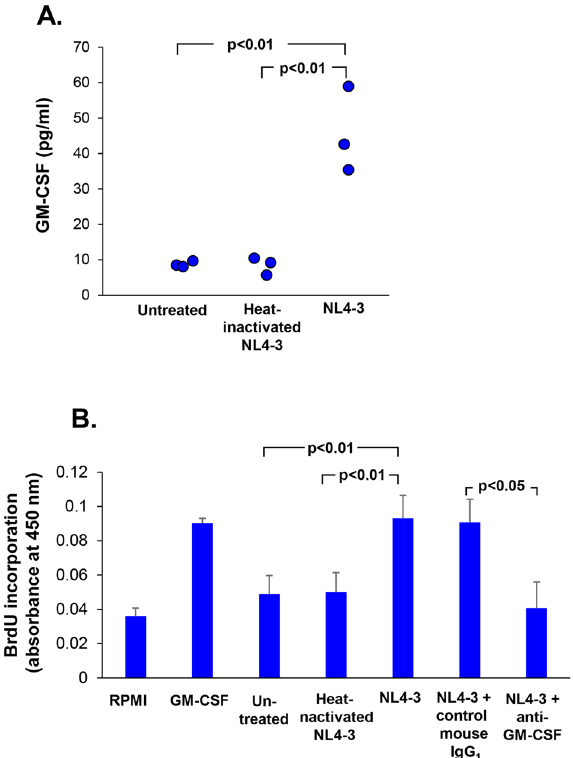
Figure 5. HIV-treated BC release GM-CSF that stimulates AM proliferation. ( A) Quantification of GM-CSF in BC-conditioned medium by ELISA. ( B) Proliferation of human AM is partially mediated by BC-released GM-CSF in conditioned media. Alveolar macrophages in serum-free RPMI were plated in 96-well and incubated with BC-conditioned media from untreated, HIV-treated and heat-inactivated HIV-treated BC culture. RPMI and recombinant GM-CSF (20 ng/ml) serve as background and positive controls, respectively. BC-conditioned media were pre-treated with mouse IgG 1 control and anti-GM-CSF neutralizing antibody (both at 10 µg/ml) for 30 min prior to addition to the cells. Cell proliferation was measured by BrdU incorporation assay after 3 days of culture. Data represent the mean ± SD of one representative experiment (n = 3) performed in